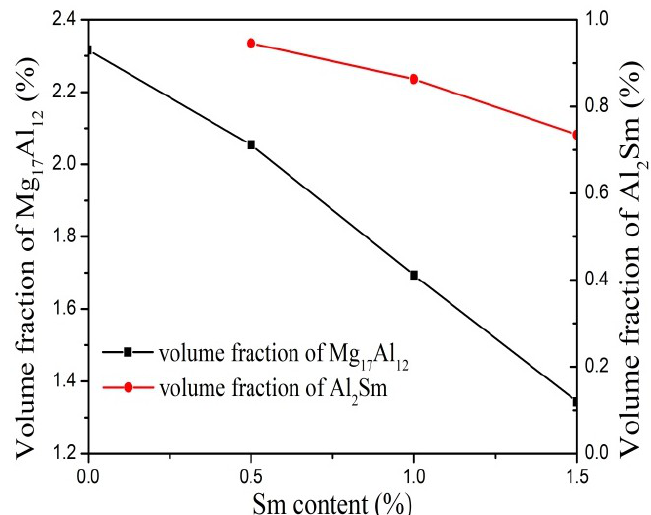
Figure 6. The volume fraction of β-Mg 17 Al 12 and Al 2 Sm particles in ultrasonic-treated AZ91–xSm (x = 0, 0.5, 1.0, 1.5 wt %) magnesium alloys.